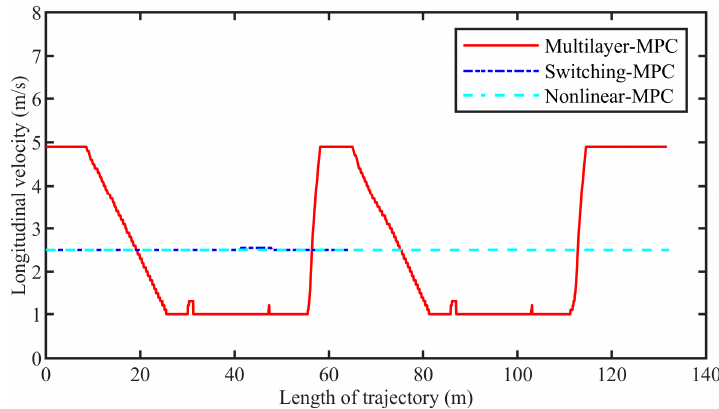
Figure 5. The longitudinal velocity of the comparison between controllers.